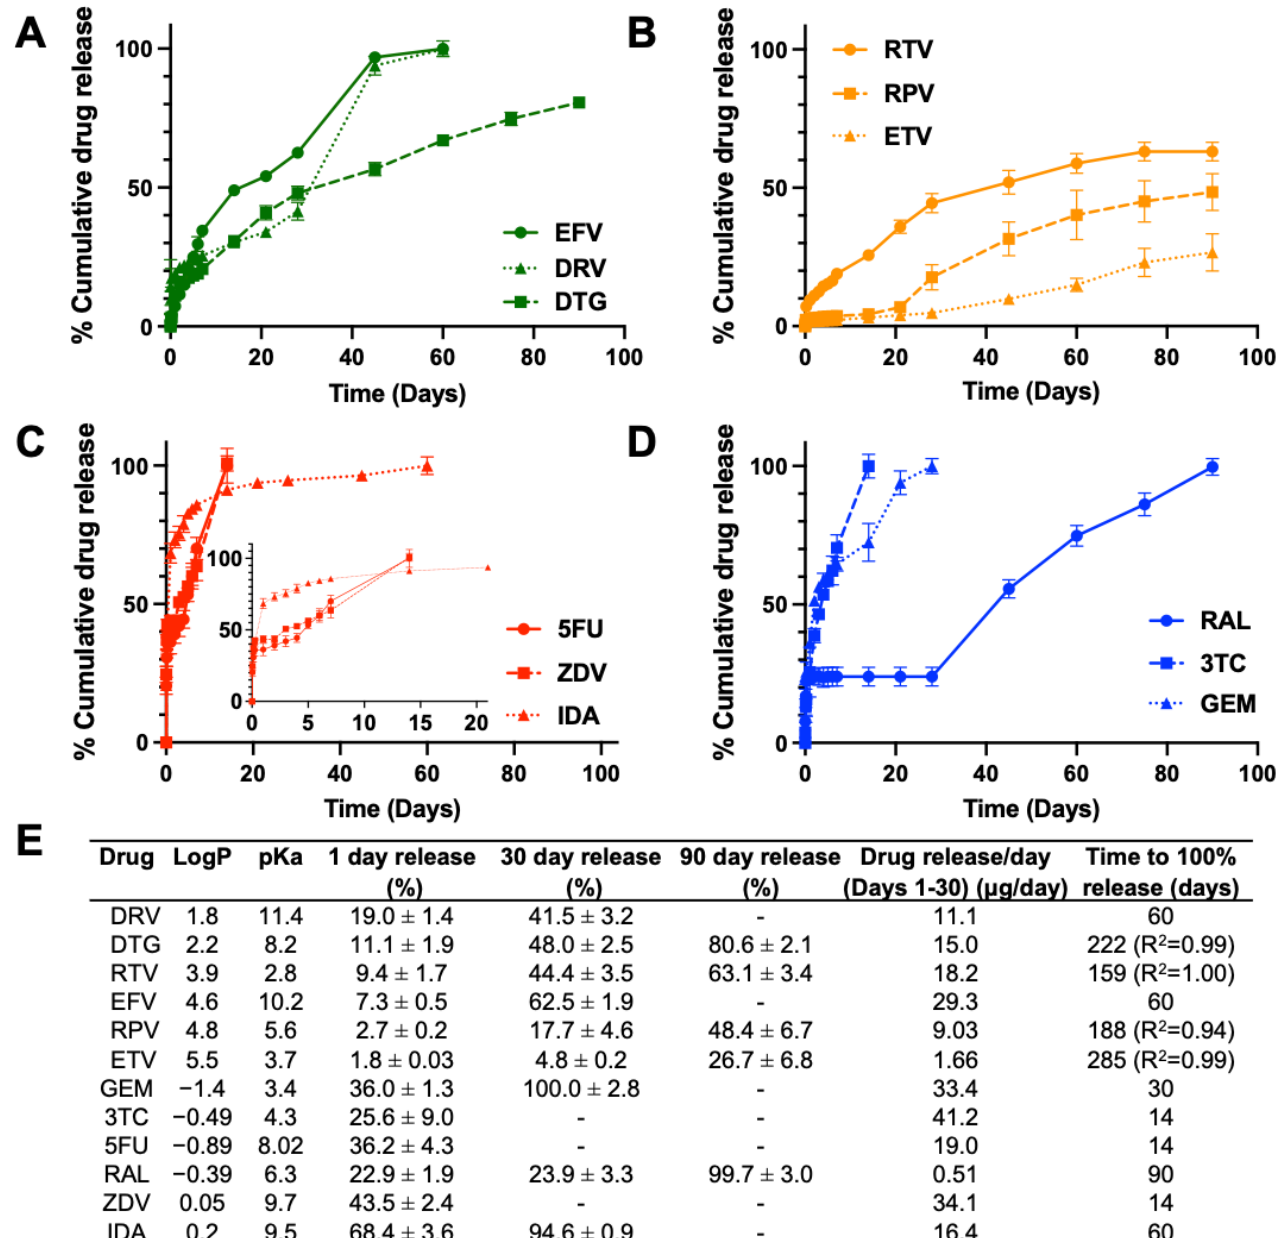
Figure 3. Cumulative percentage in vitro drug release kinetics from drug-loaded ISFIs (50 mg/g drug in 1:2 PLGA:NMP) over a course of 90 days for ( A ) hydrophobic–basic drugs, ( B